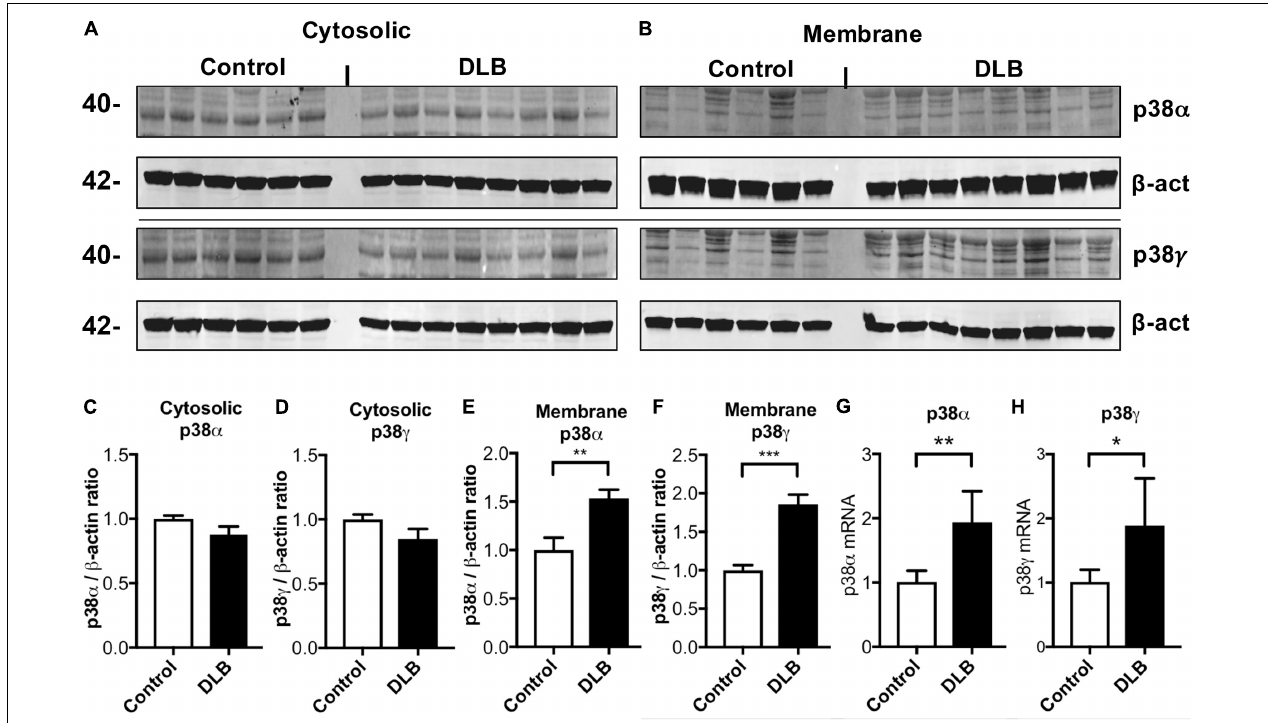
FIGURE 3 | Immunoblot and RNA analysis for p38 α and γ in DLB and control brains. Human frontal cortex samples were separated into cytosolic and membrane fractions by extracting sequentially with Tris and PDGF buffer and probed with p38 α , p38 γ , and β -actin. (A , B) Representative immunoblot images for (A) cytosolic and (B) membrane fractions probed with p38 α , p38 γ , and β -actin. In each panel, left six lanes show healthy controls and right eight lanes show DLB patients. (C,D) Image analysis of the cytosolic fraction immunoblot for p38 α and p38 γ , respectively. (E,F) Image analysis of the membrane fraction immunoblot for p38 α and p38 γ , respectively. (G , H) Real time qPCR for p38 α and p38 γ mRNA, respectively. n = 6 for control and n = 8 for DLB (* p < 0.05, ** p < 0.01, *** p <